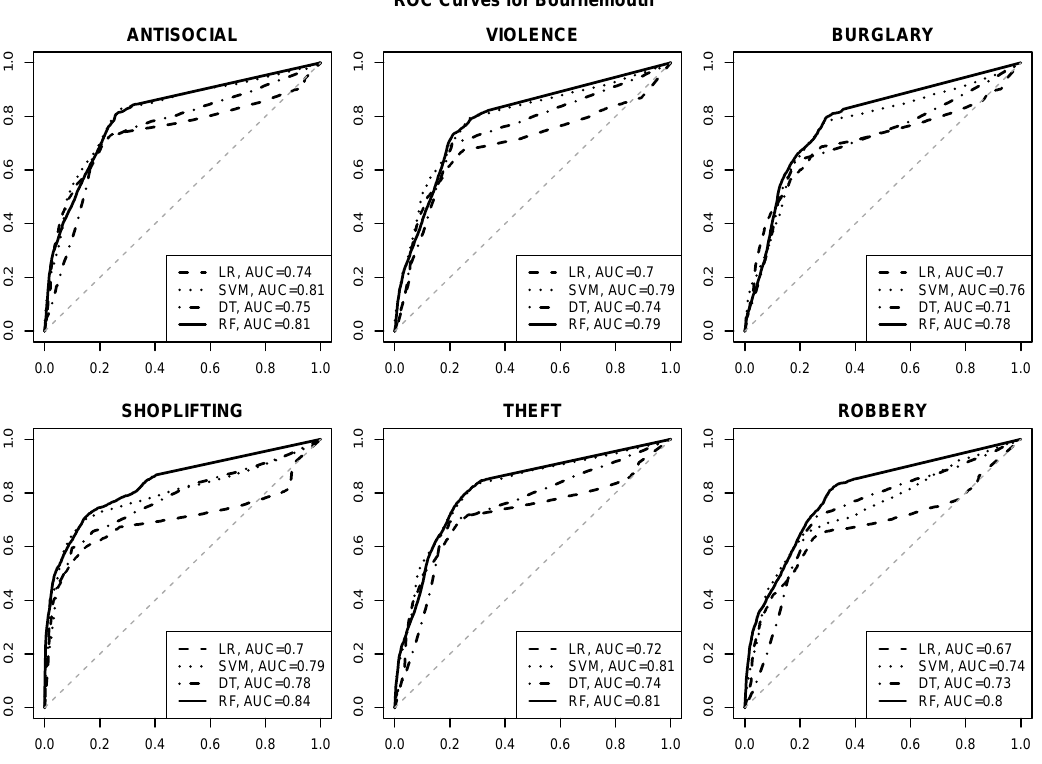
Figure 8. The ROC curves for crime risk prediction in Bournemouth.